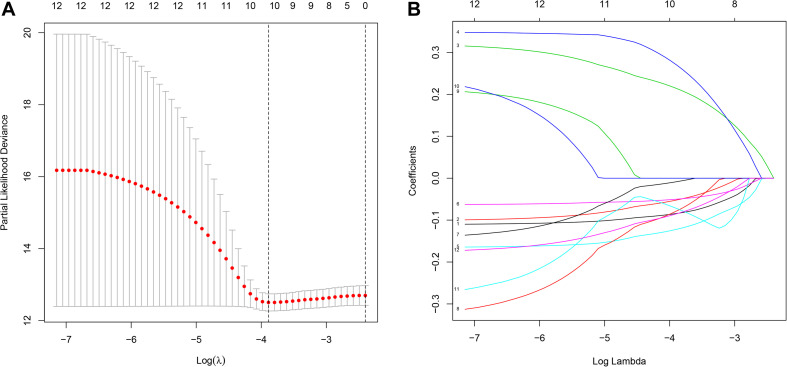
Construction of the prognostic prediction model for patients with ovarian cancer by LASSO. (A) The changing trajectory of each independent variable. The horizontal axis represents the log value of the independent variable lambda, and the vertical axis represents the coefficient of the independent variable. (B) Confidence intervals for each lambda. The horizontal axis represents the log value of the independent variable lambda, and the vertical axis represents the error of cross-verification.